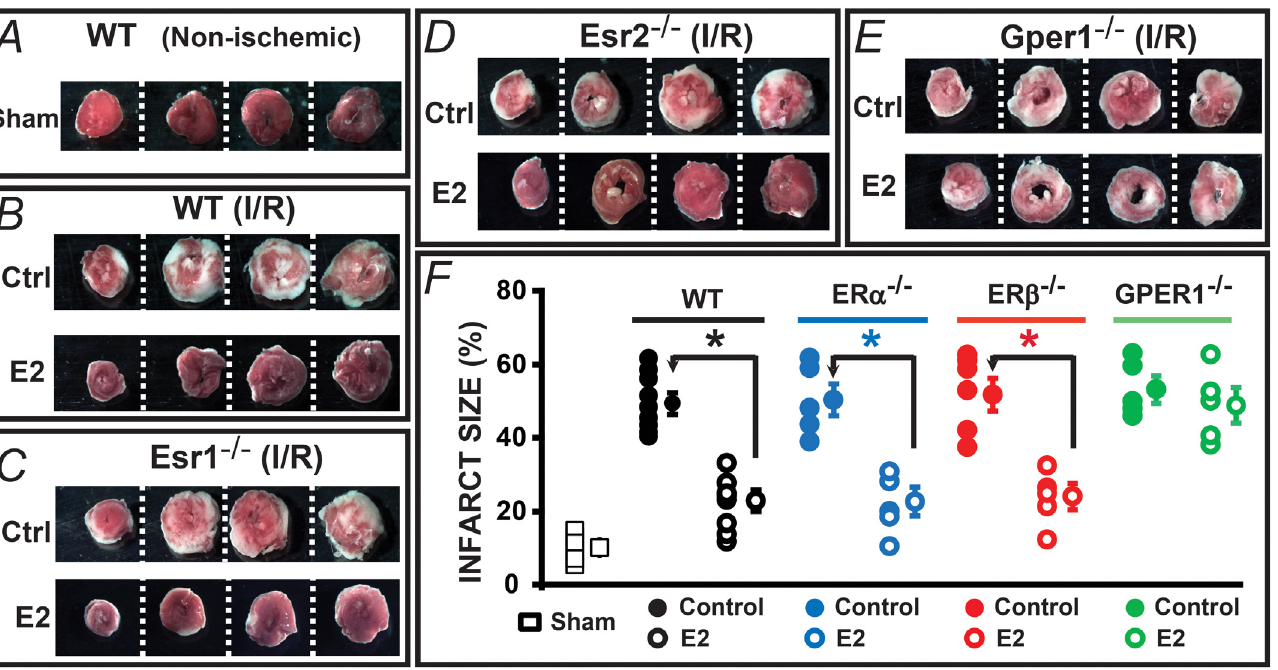
Fig 4. Gper1 activation is required to protect the heart from infarct induced by I/R. Hearts were treated as in Fig 2 and analyzed at the end of each protocol. A-E. Images are from slices of the same heart in each condition. White areas correspond to the infarcted zone. A. Infarct is minimal in isolated hearts not subjected to I/R. B-D. E2 protected equally well hearts from WT, Esr1 and Esr2 knockouts against infarct induced by I/R. E. Gper1 -/- was the only E2 receptor knockout examined where I/R caused the same degree of infarct in the presence or absence of E2. F. Individual and mean ± SEM values of % infarct size. * P < 0.05 control versus E2-treated groups (WT, n = 7 – 8 hearts/group; Esr1 -/- , n = 5 hearts/group; Esr2 -/- , n = 5 – 6 hearts/group). In Gper1 -/- hearts, E2 treatment did not reduce the infarct size (control = 52 ± 3% vs . E2-treated = 47 ± 4%, n = 6 hearts/group).